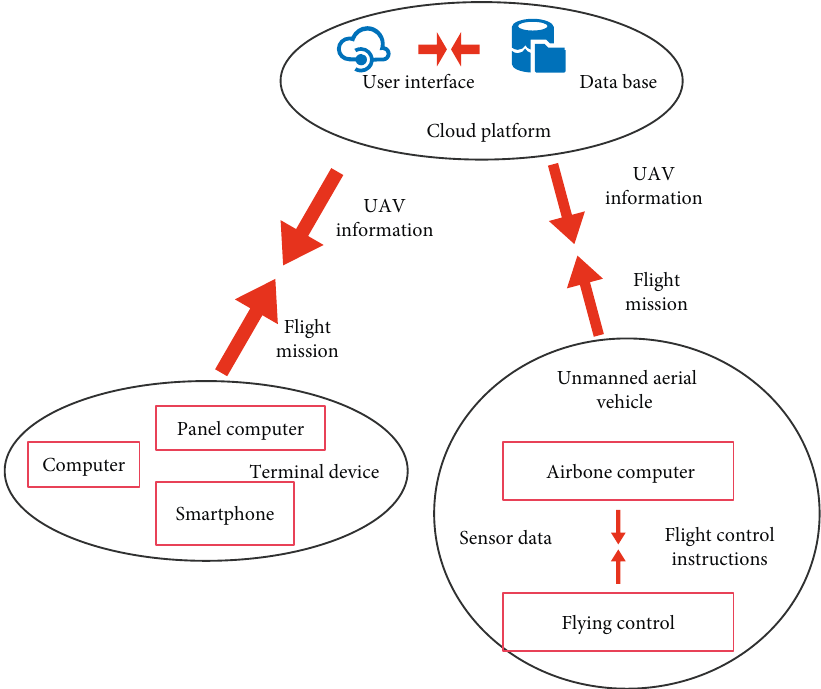
Figure 10: Schematic diagram of the scheme. Table 1: Machine vision effect